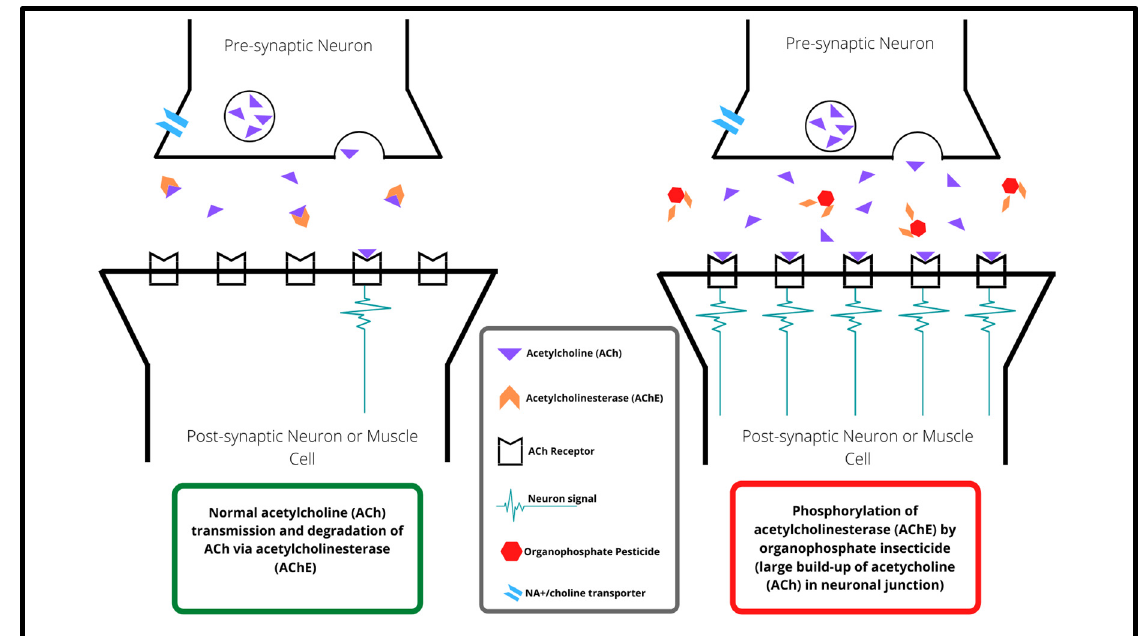
Figure 1. The physiological action of acetylcholine (ACh; purple triangles) at the neuronal cell synapse, the breakdown of ACh through acetylcholinesterase (AChE; orange diamonds), and the phosphorylation of AChE through organophosphate insecticide (OP; red hexagons) exposure.